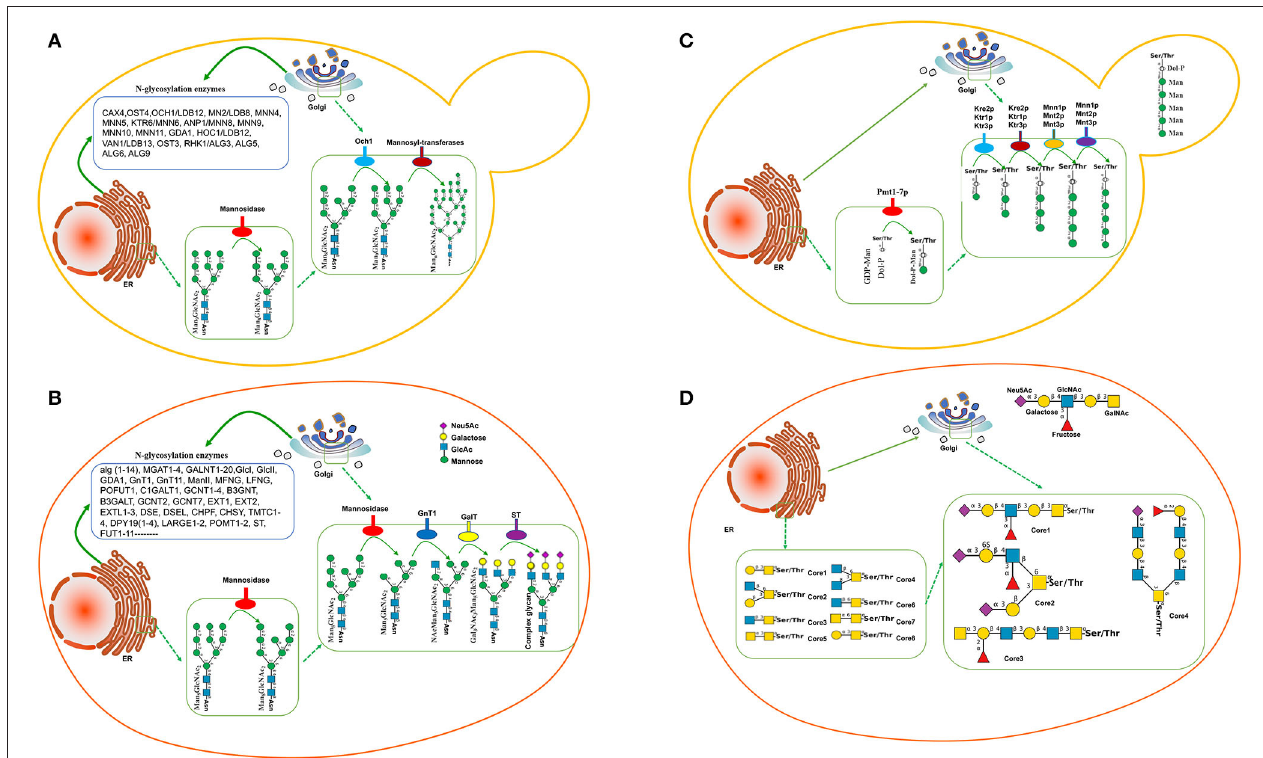
FIGURE 1 | Glycosylation pathway between yeasts and mammalian cells. (A) N-glycosylation pathway in yeasts. (B) N-glycosylation pathway in mammalian cells. (C) O-glycosylation pathway in Saccharomyces cerevisiae . In the ER, the first mannose residue is added via protein-O-mannosyltransferases (Pmt1-7p). O-glycosylation is further elongated in the Golgi via several mannosyltransferases. (D) Mucin-type O-glycan synthesis in human